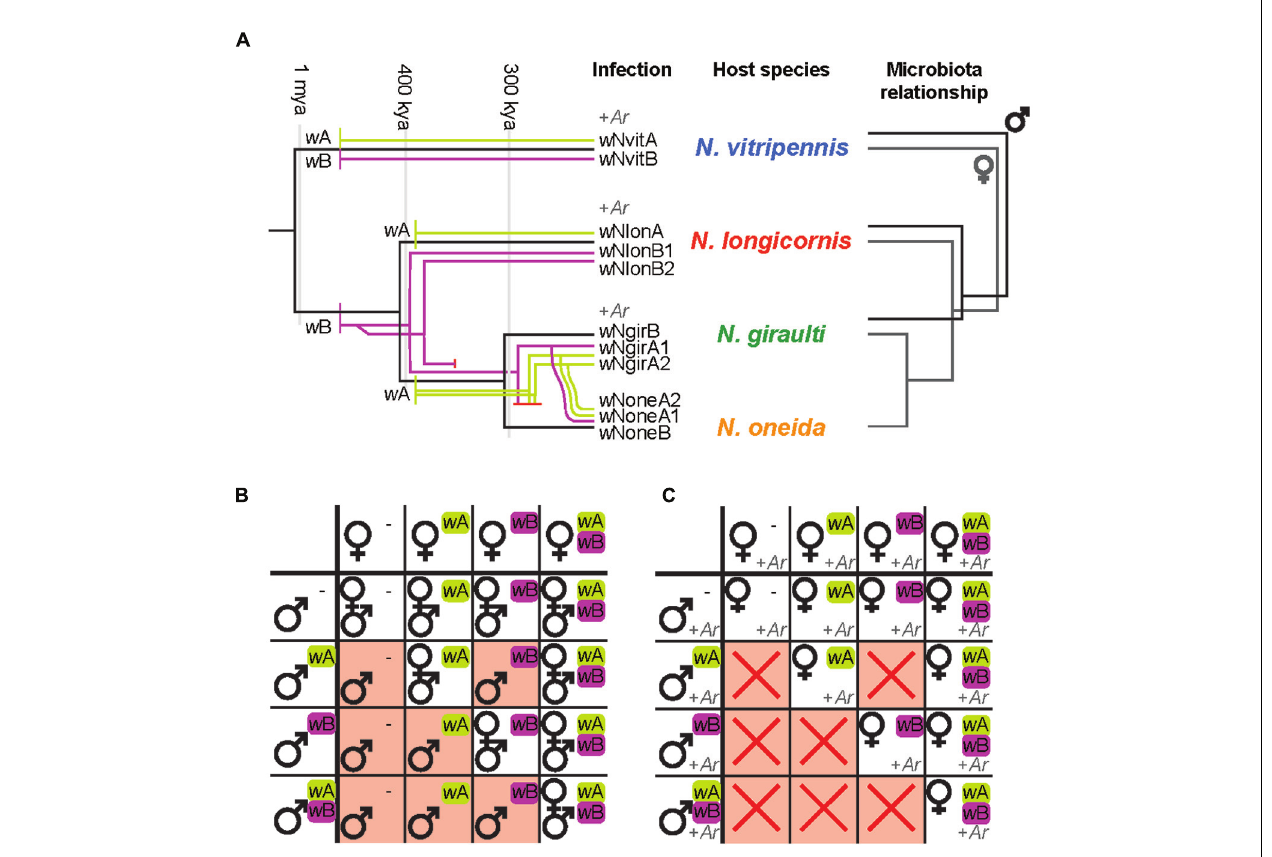
FIGURE 3 | (A) Wolbachia − Nasonia associations and phylosymbiosis (modified from Raychoudhury et al., 2009; Brucker and Bordenstein, 2012b,c). Wolbachia acquisitions and subsequent divergence are overlaid on the Nasonia phylogeny. Strains from Wolbachia supergroup A are represented in green, strains from supergroup B in purple. Arsenophonus ( + Ar ) has been found to infect three species of Nasonia . The microbial community relationships parallel the host phylogeny, indicating species-specific microbiota assemblies that establish phylosymbiosis. This pattern has been observed in males for three species (Brucker and Bordenstein, 2012b, 2013) as well as in females for all four species (R. M. Brucker and S. R. Bordenstein, personal communication). (B) Impact of Wolbachia -induced CI on offspring production. Wolbachia present in males induce a sperm modification that needs to be rescued by the same Wolbachia strain in the fertilized egg for normal offspring production. CI (red background) occurs if the female is uninfected (-) (unidirectional CI) or harbors a different Wolbachia strain (bidirectional CI) and results in male-only (or male-biased) broods due to loss of the paternal chromosomes. Note that although Wolbachia modify male sperm, the symbiont is only maternally transmitted. Offspring will therefore harbor the same Wolbachia strain(s) as their mothers. w A/ w B indicate different Wolbachia strains. (C) Impact of Arsenophonus -induced male-killing on offspring production, in combination with Wolbachia -mediated CI. Male-killing results in all-female broods in the absence of CI (white background) and no offspring production in combination with CI (red crosses), since the males that are not affected by CI would be killed by